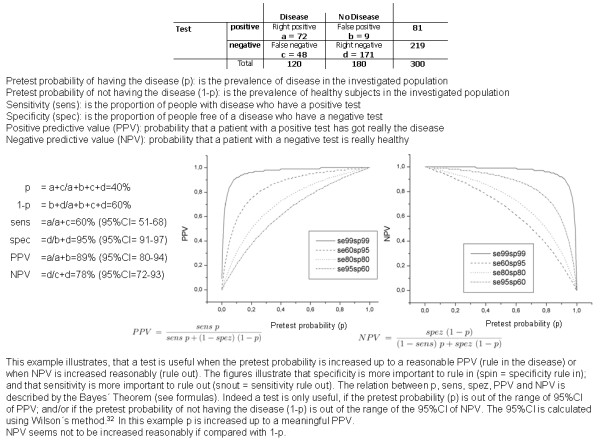
Calculation example for the relation between pretest probability, sensitivity, specificity, PPV and NPV.